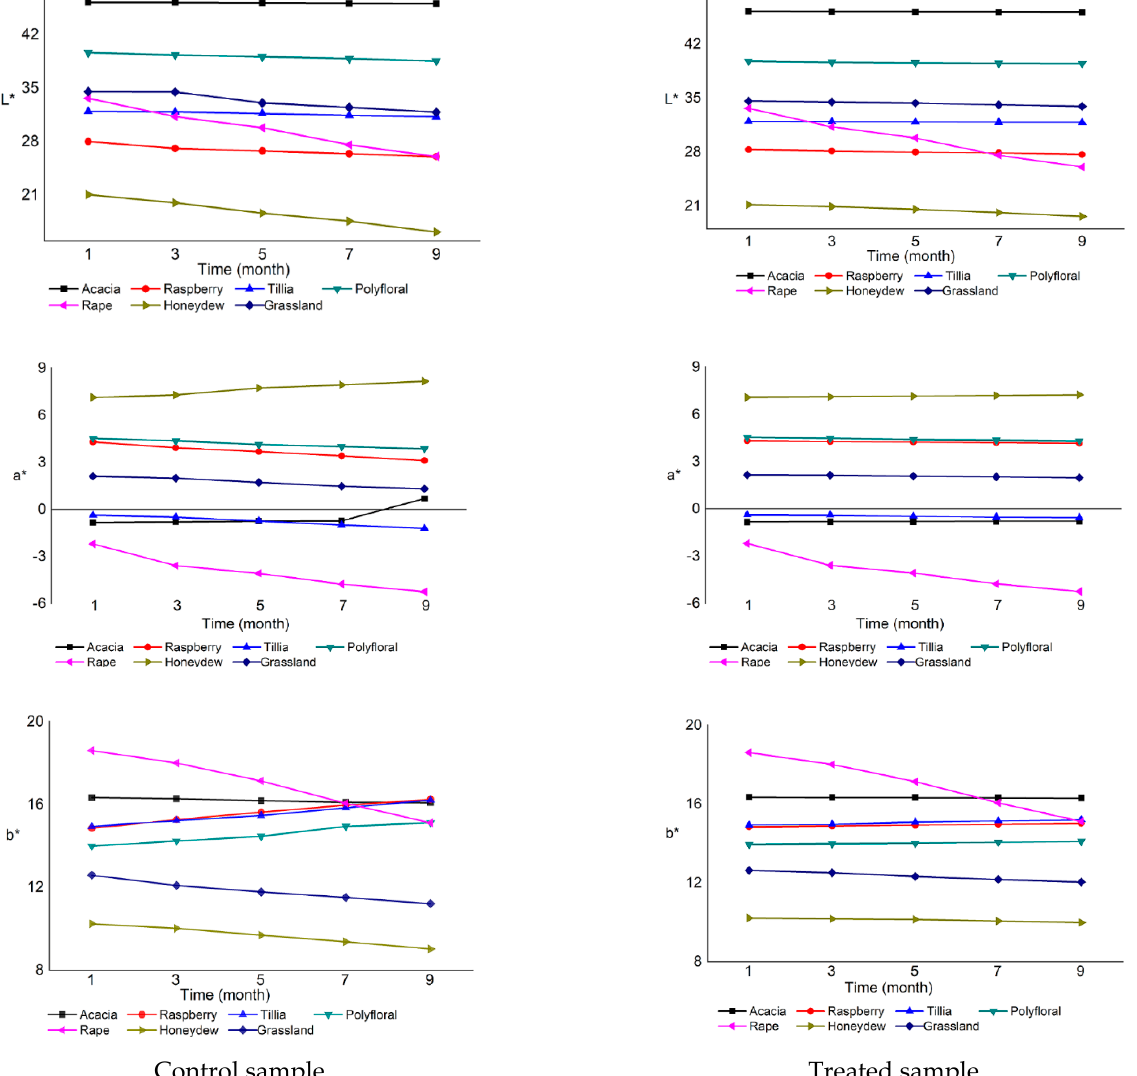
Figure 1. Color parameters for the seven honey samples.